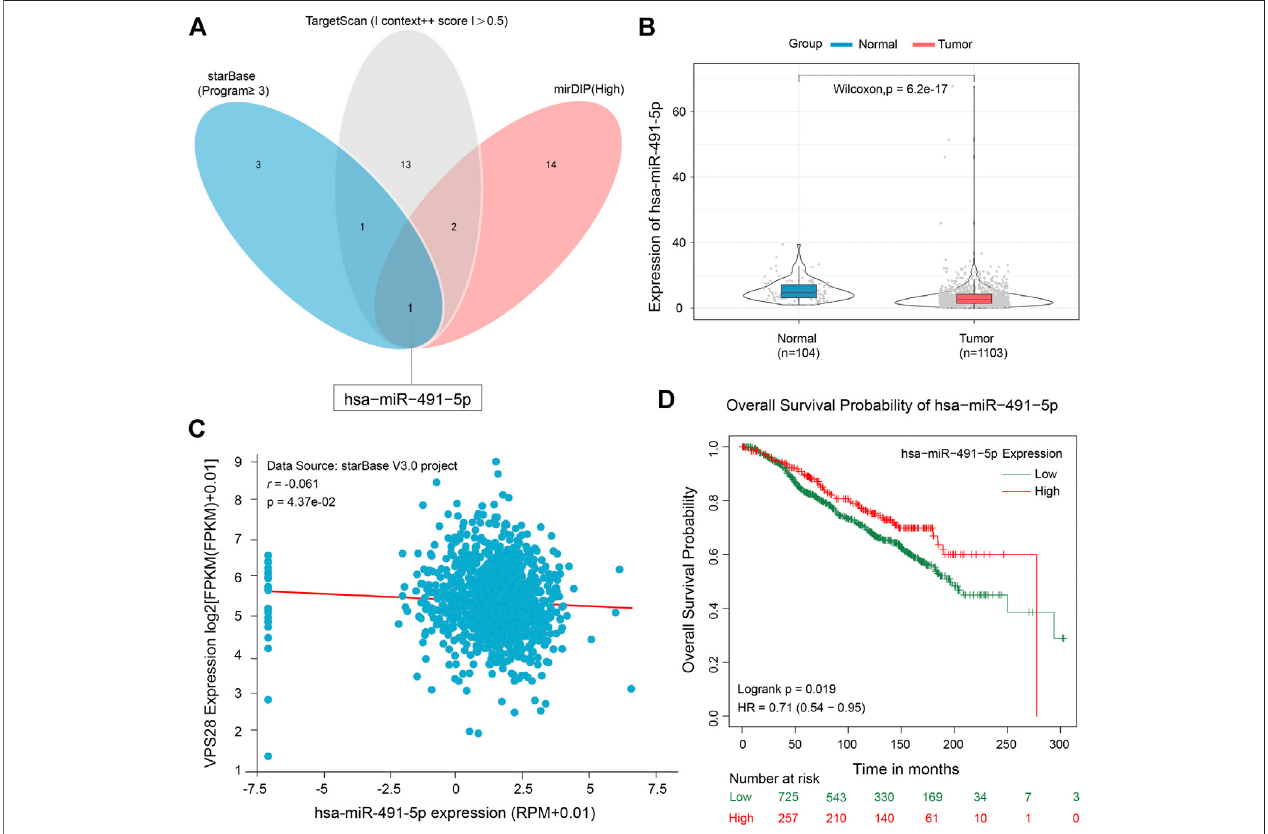
FIGURE5| MicroRNA-491-5p cannegativelytargetVPS28.AVenndiagramoftheupstreamtargetsofVPS28asassessed bystarBase,TargetScan,andmirDIP (A) .TheexpressionpatternofmiR-491-5p inbreastcancerusingTCGA data (B) .ThecorrelationbetweenmiR-491-5p andVPS28levelswasanalyzedinbreastcancer tissues (C) . The effect of miR-491-5p on the overall breast cancer patient survival rate according to the TCGA database (D)